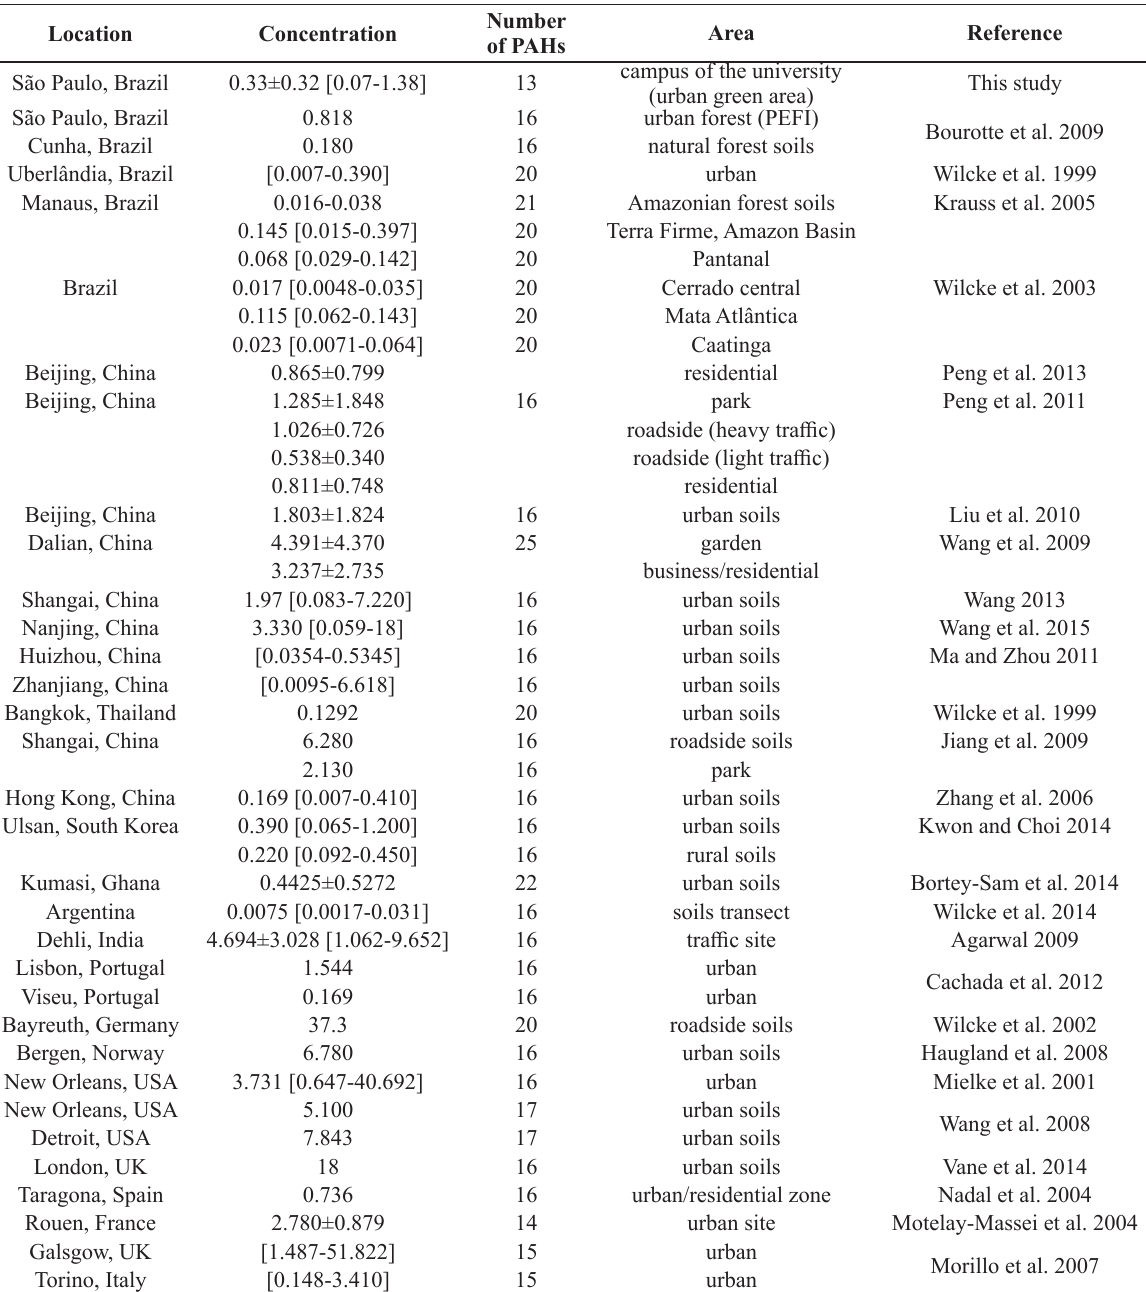
Comparison of average PAHs concentrations (in mg kg -1 ) in this study and in world topsoils. Location